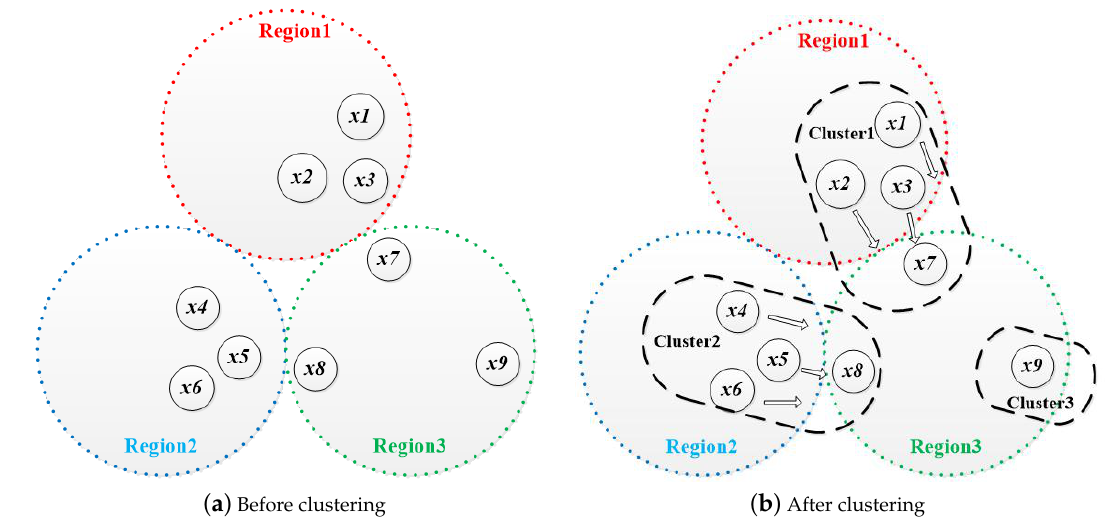
Figure 1. An example of clustering based on k-means algorithm.